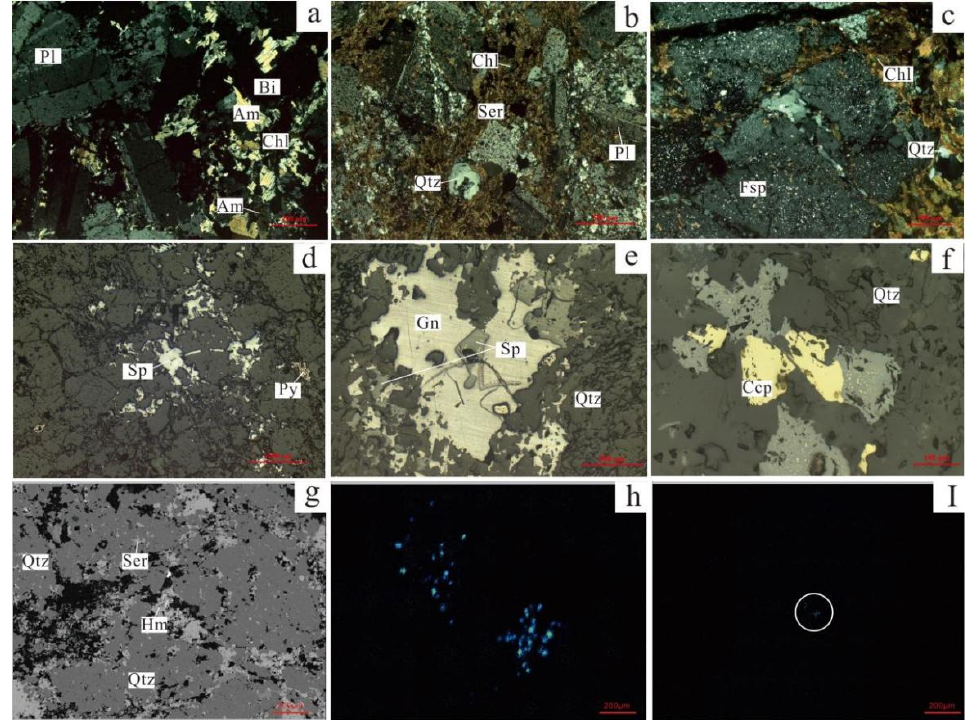
Figure 3. ( a – c ) Photomicrographs of fragmented and altered minerals (cross-polarized light); ( d – f ) photomicrographs of ore metasomatism (plane-polarized light); ( g ) morphology of minerals; and ( h , i ) cassiterite distribution map obtained using SEM.